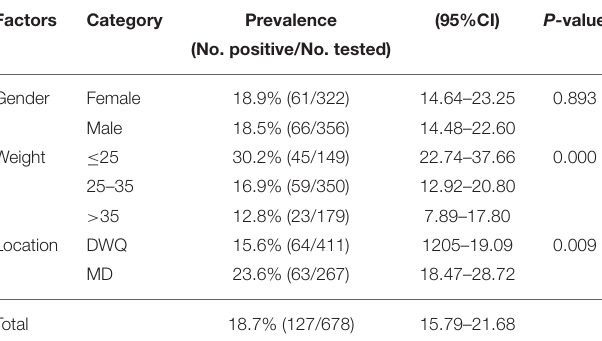
TABLE 1 | Prevalence and distribution of Cryptosporidium species/genotypes in Brandt’ voles in Inner Mongolia,